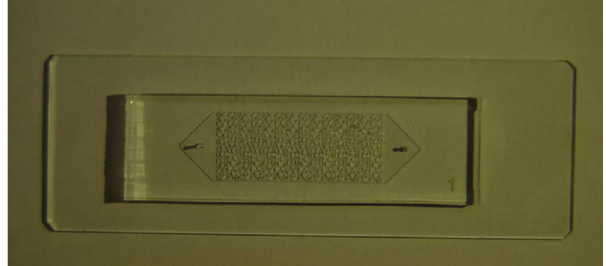
Figure 2: Picture of a micro fl uidic porous